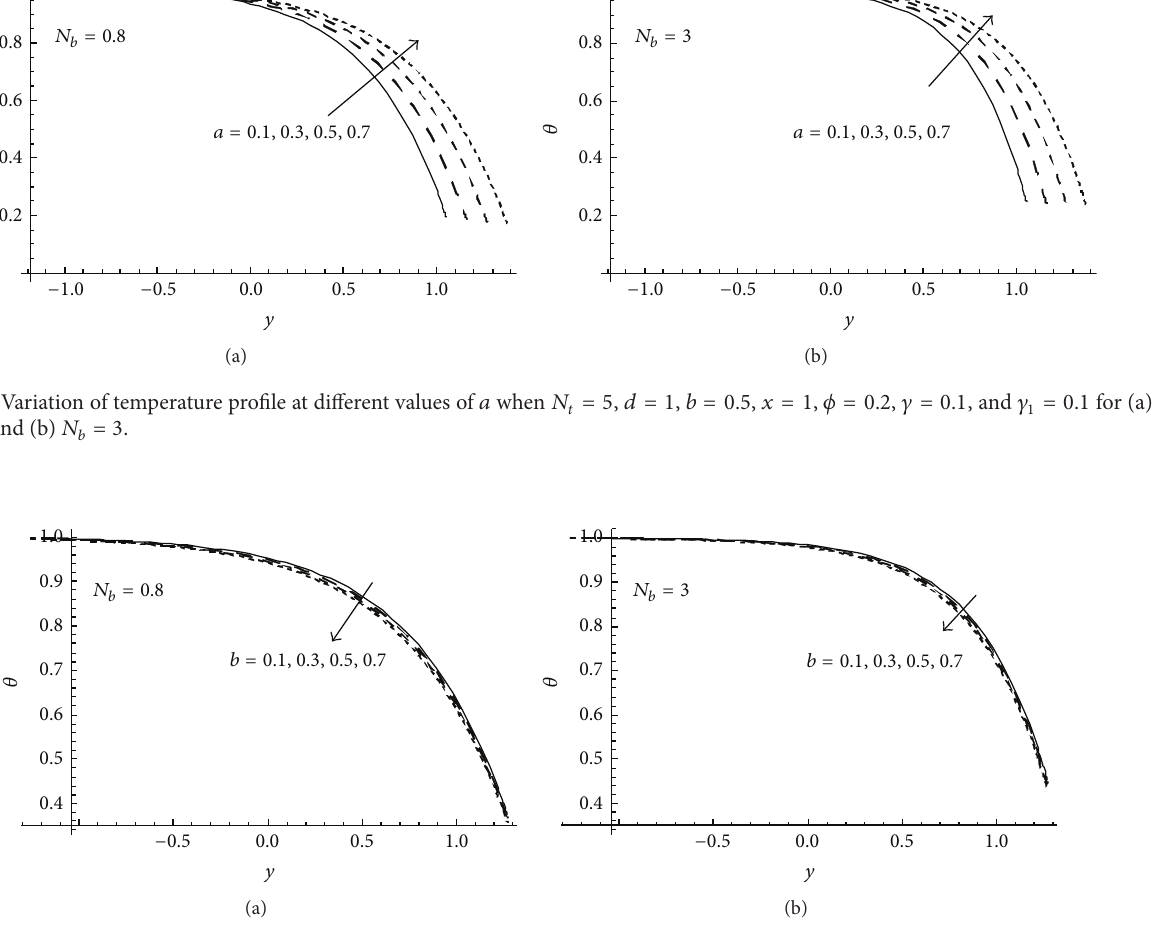
Figure 3: Variation of temperature profile at different values of 𝑏 when 𝑁 𝑡 = 5 , 𝑑 = 1 , 𝑎 = 0.5 , 𝑥 = 1 , 𝜙 = 0.2 , 𝛾 = 0.3 , and 𝛾 1 = 0.3 for (a) = 0.8 and (b) 𝑁 = 3 . 𝑁 𝑏 𝑏